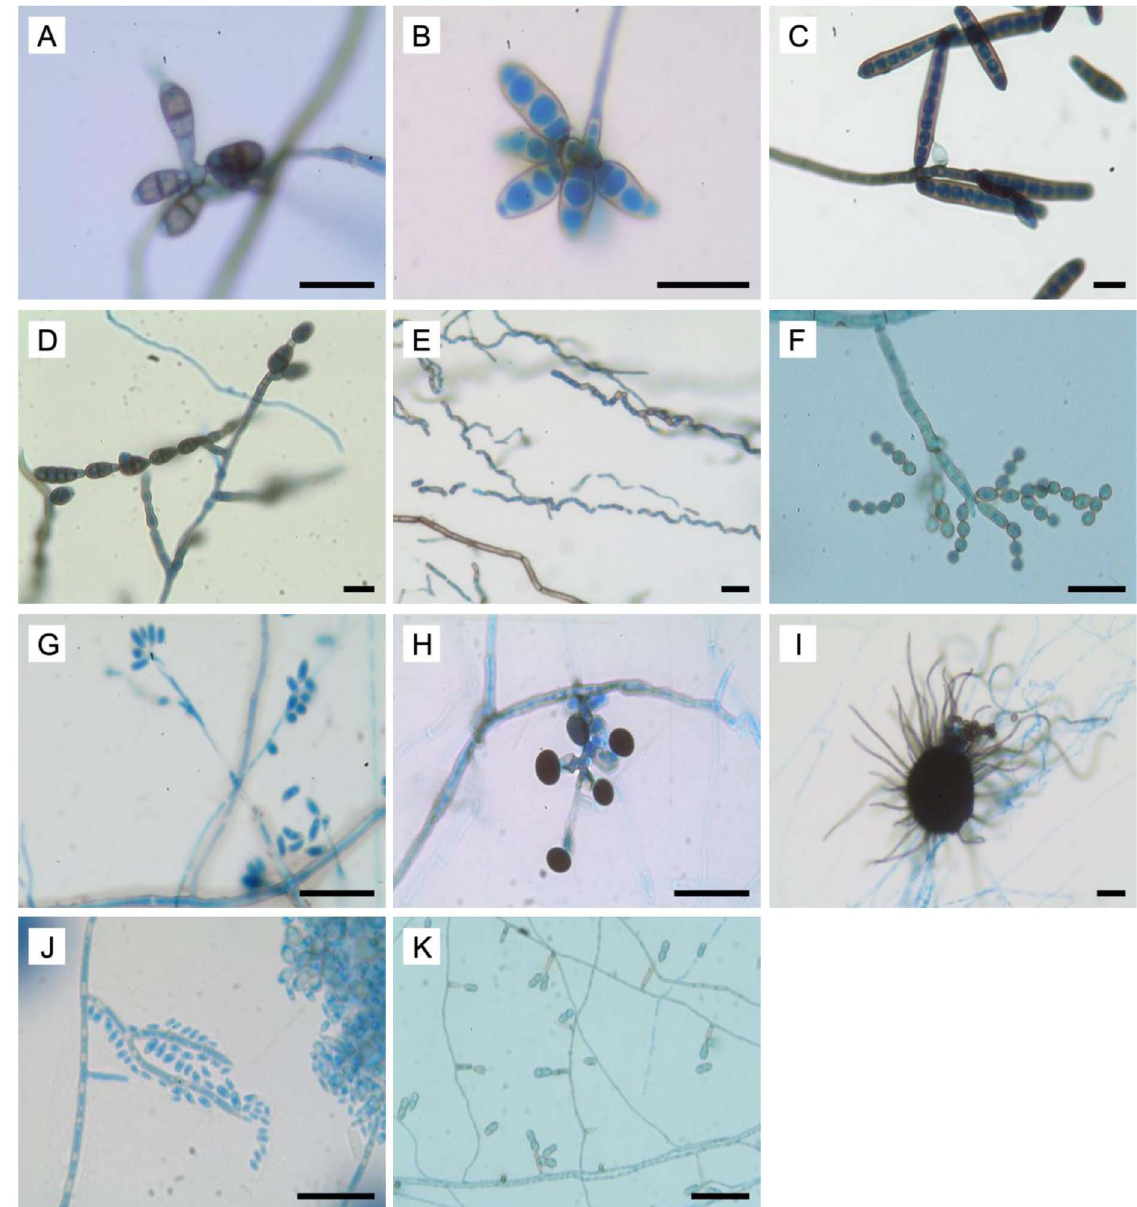
Figure 1. Microscopic features of dematiaceous fungi. (A-D) Macroconidia of Curvularia , Bipolaris , Exserohilum and Alternaria (E) Arthroconidia of Neosyctalidium (F) Globose chain conidia and ramoconidia of Cladosporium (G) conidia of Daldinia (H) Dark conidia of Nigrospora (I) Chaetomium perithecium covered with long setae and dark ascospores (J) Spine-like conidiophore and hyaline conidia of Exophiala (K) Ochroconis two-celled clavate conidia with cylindrical conidiophore. Bars 20 m m.